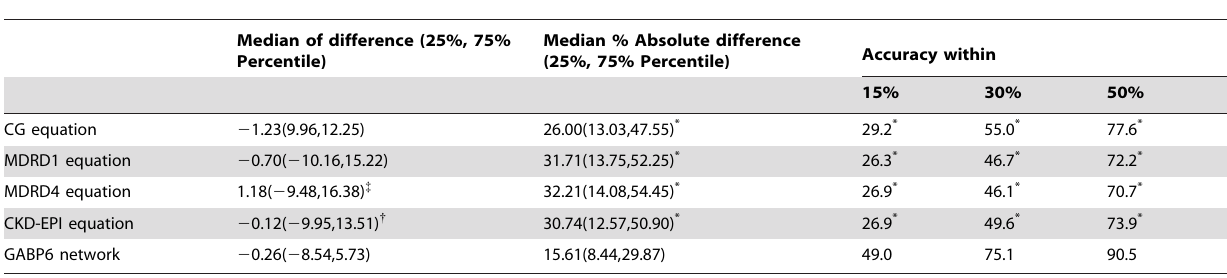
Table 3. Overall performance of difference and accuracy between eGFR and sGFR in the external validation data set.